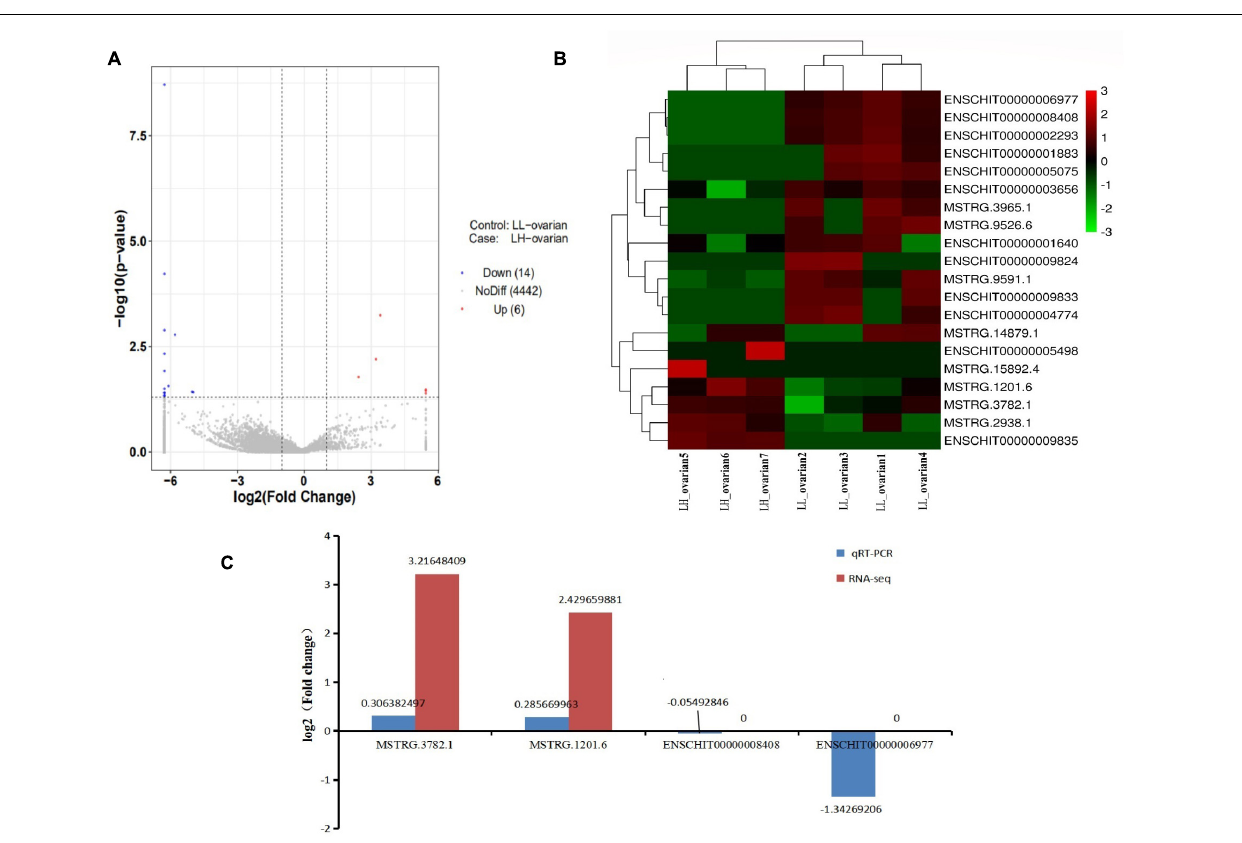
FIGURE 1 | Analysis and validation of DElncRNAs in RNA-seq libraries. (A) Volcano map in analyzing DElncRNAs between high fecundity group and low fecundity group. The red plot represented up-regulated expression in high fecundity group; the blue plot represented down-regulated expression in high fecundity group. (B) Hierarchical clustering analysis of lncRNA expression profiles from libraries with 20 DElncRNAs. Data were expressed as FPKM. Red: relatively high expression; Green: relatively low expression. (C) qRT-PCR results pertaining to DElncRNAs were compared with RNA-seq data. Red: RNA-seq; blue: